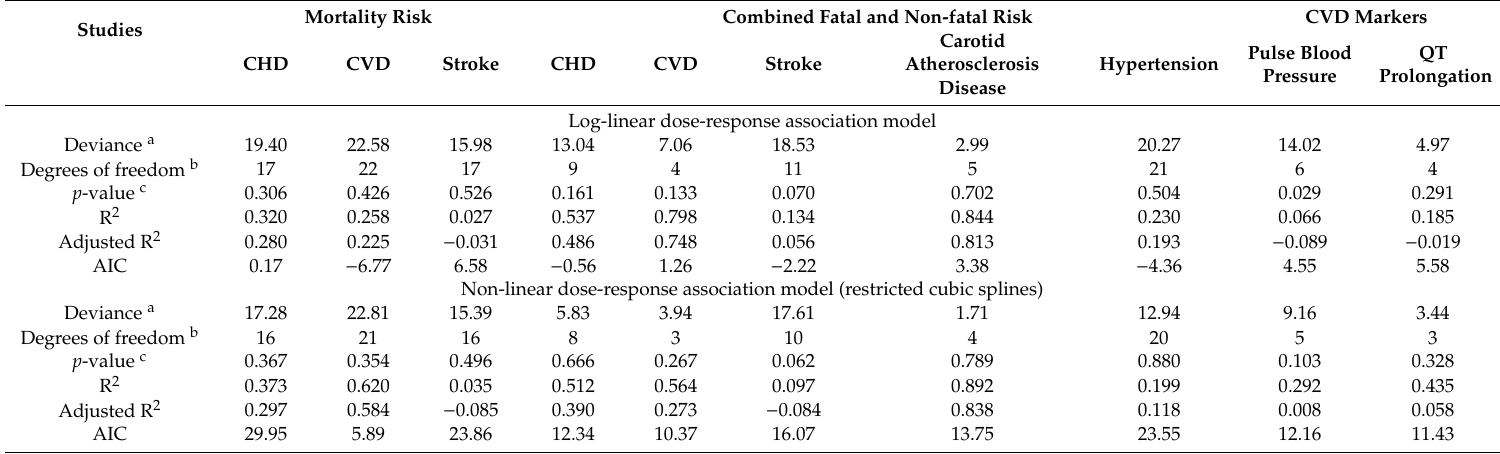
Table 3. Goodness-of-fit